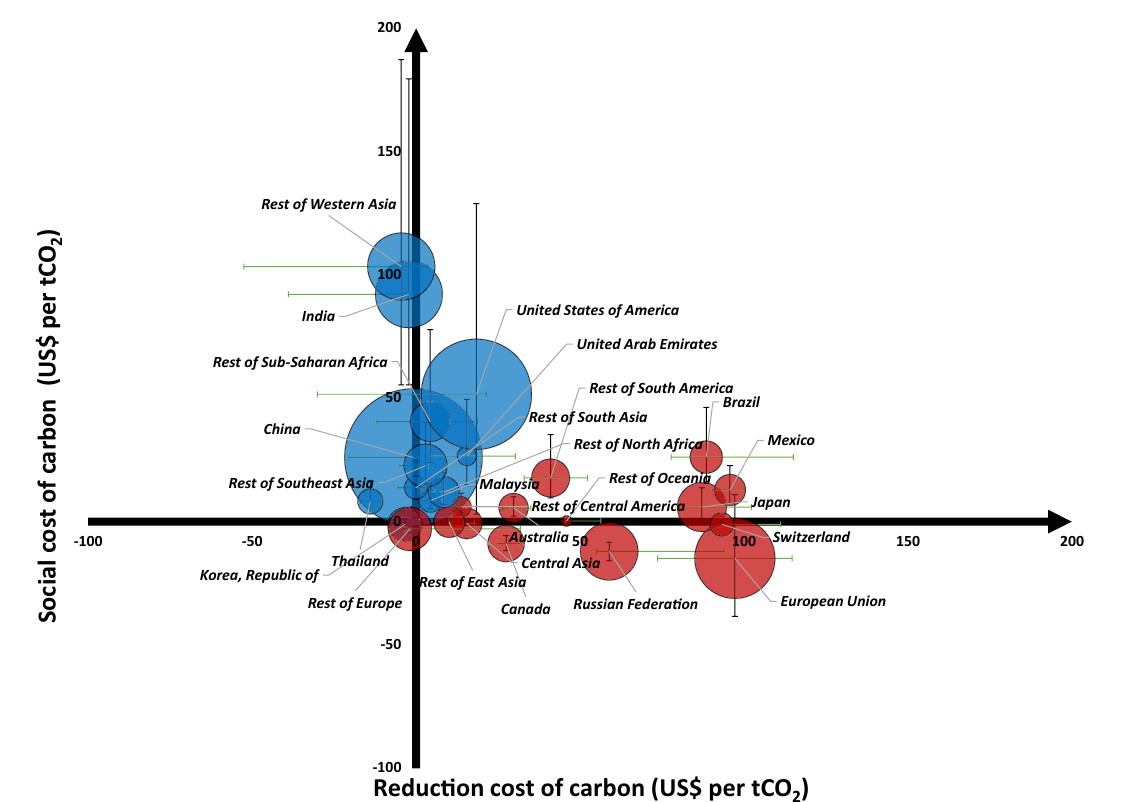
Fig. 3 Contrast between costs and bene fi ts of carbon mitigation for individual emitters. The RCC (average reduction cost of carbon) and SCC (social cost of carbon) for each country/region under SSP2-RCP4.5. The size of the dots denotes the magnitude of regions ’ CO 2 emissions. Regions with higher SCC than RCC are shown with the blue color, and regions with higher RCC than SCC are shown with red color. The vertical error bar represents the 66% CI of SCC. The horizontal error bar represents the maximum and minimum RCC values based on results from fi ve IAM